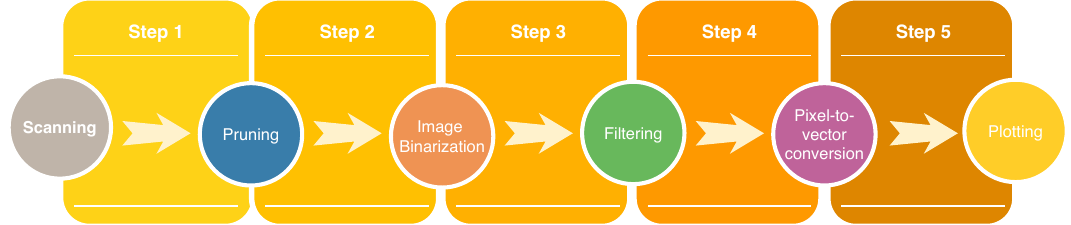
Figure 3. Block diagram showing the steps of the digitalization